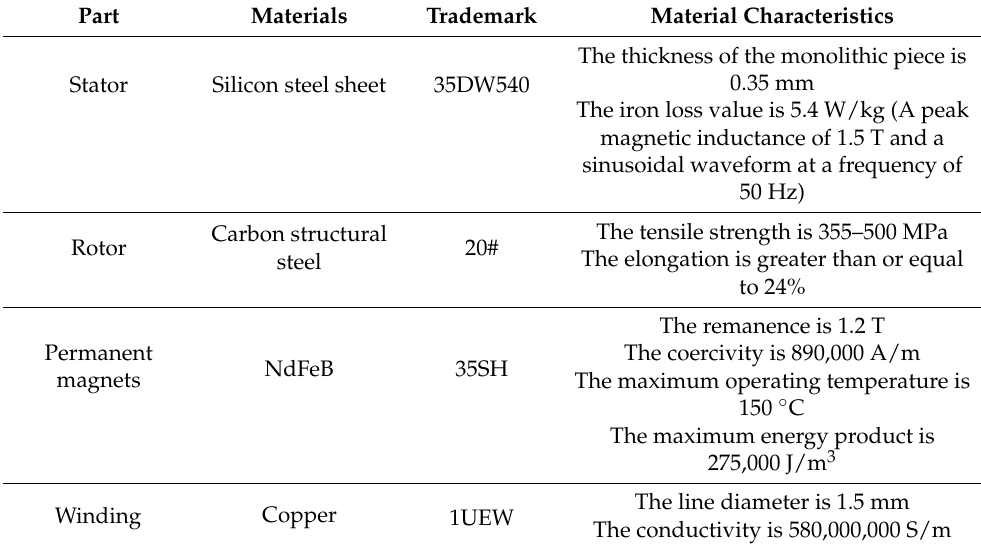
Table 5. The materials of each part and their characteristics of the permanent